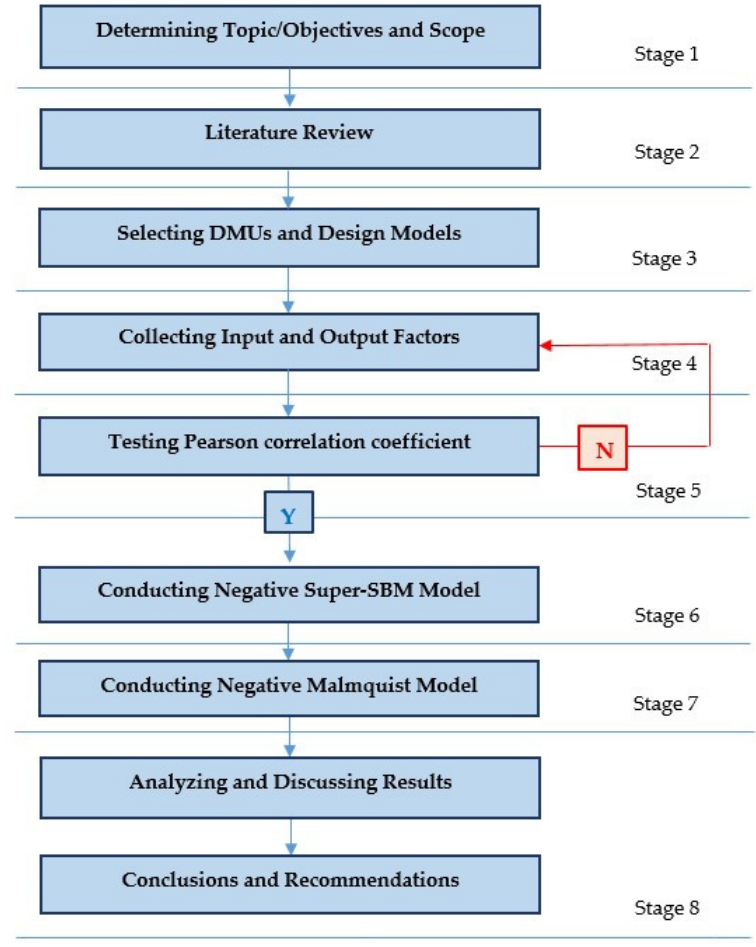
Figure 2. Research process .